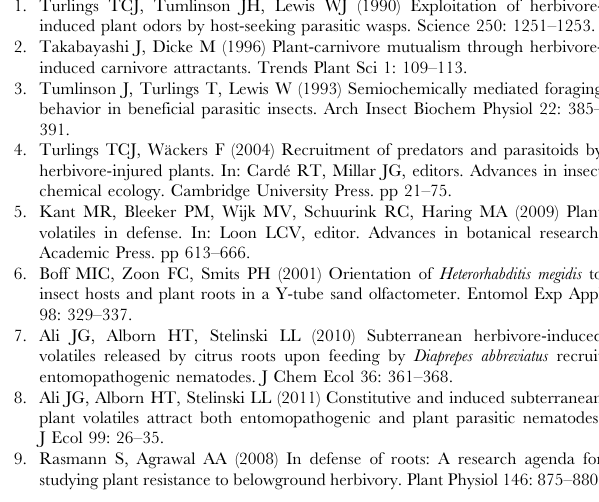
Table S2 1 H (600 MHz), 13 C (151 MHz), HMBC and NOESY NMR spectroscopic data for geijerene in C 6 D 6 . 13 C was also detected directly (126 MHz) using a 5 mm Cryoprobe.